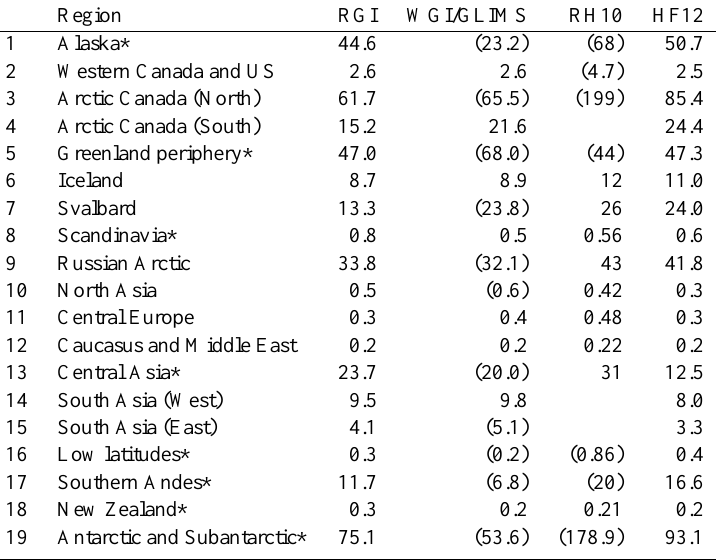
Table 6. Estimated total volume of ice (mm SLE) by region (see Fig. 1) for the two inventories. Numbers in parenthesis mark numbers with known inventory deficiencies (see text). The volumes for the closest corresponding regions estimated by RH10 (Radi´c and Hock, 2010) and HF12 (Huss and Farinotti, 2012) are shown for